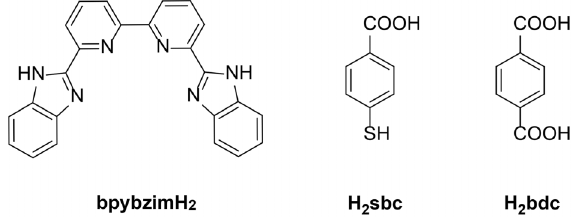
Figure 1. Chemical drawings for the organic ligands in this